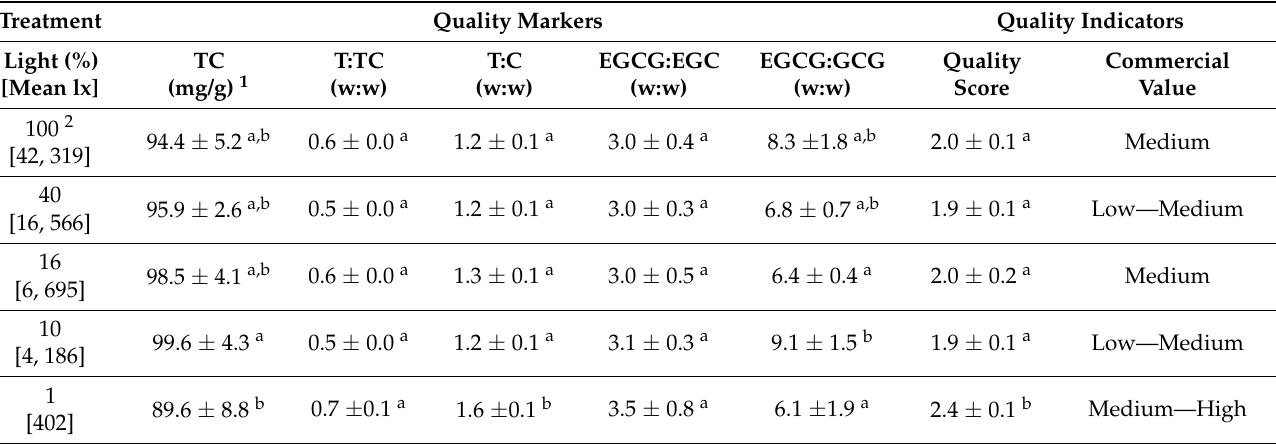
Table 2. Quality markers and quality indicators of green tea plants grown under various ambient light